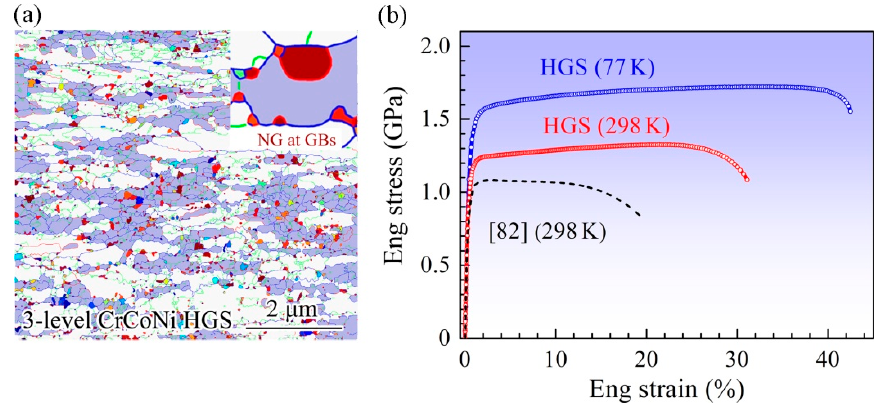
Figure 1. Microstructural characteristics and enhanced strength–ductility synergy of the MEA with HGS: ( a ) Architected HGS; ( b ) Engineering tensile stress–strain curves for the MEA with HGS under various testing temperatures. Adapted from [17].